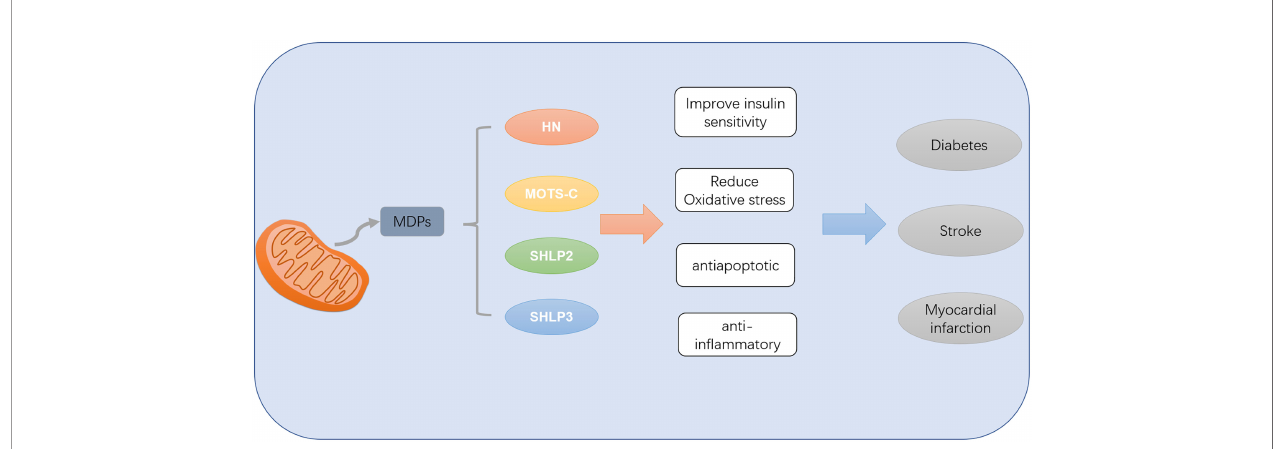
FIGURE 2 | MDPs can improve diabetes mellitus and its complications of myocardial infarction and stroke by improving insulin sensitivity and reducing oxidative stress in fl ammation and